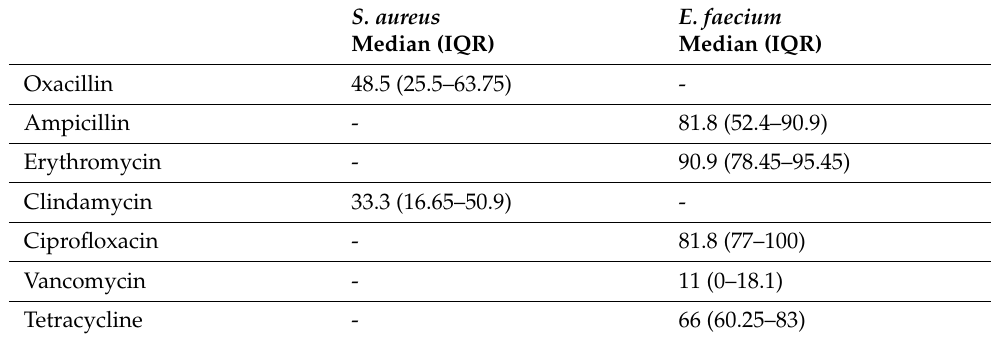
Table 3. Gram-positive bacteria resistant to tested antibiotics during